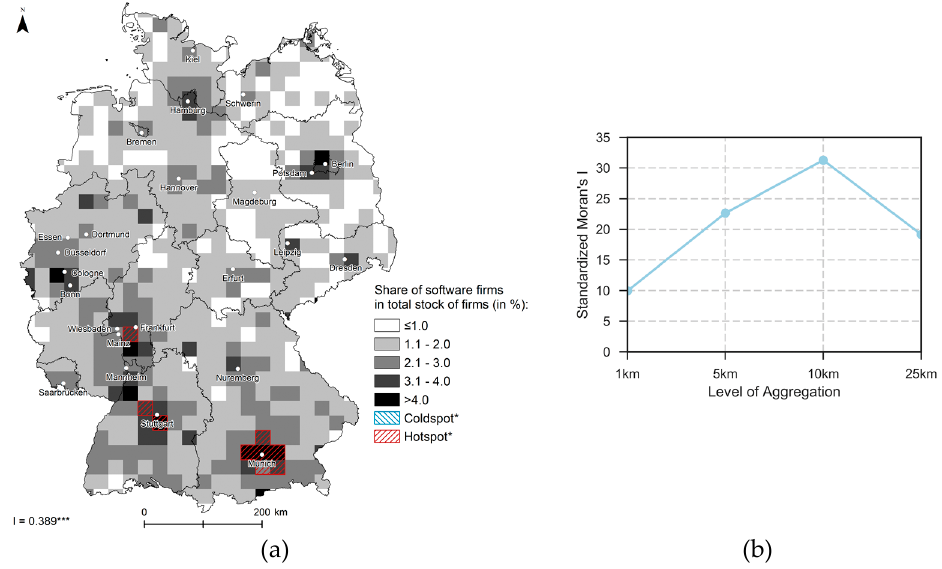
Figure 2. ( a ) Share of software firms in total stock of firms (25 km scale); ( b ) and standardized Moran’s I by 1 km, 5 km, 10 km, and 25 km level of aggregation.